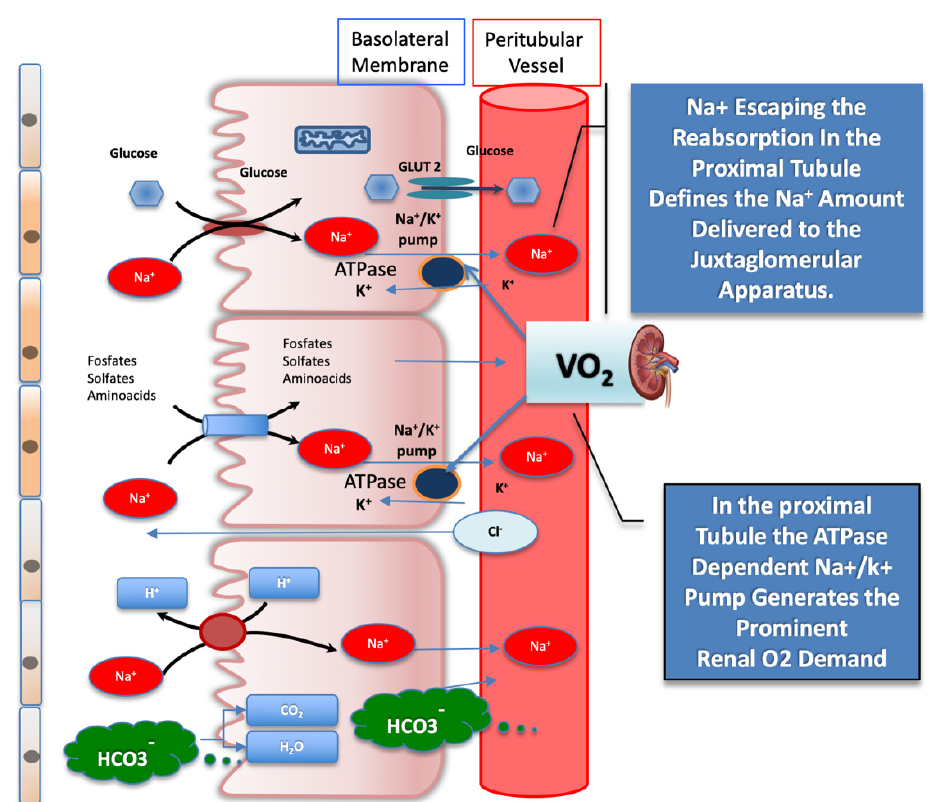
Figure 2. Schematic illustration of filtrates reabsorbed from the glomerular proximal tubule activated by sodium-glucose co-transporter (SGLT) 2, which operates in the glomerular proximal tubule. The SGLT2, the bicarbonate reabsorption, and the Na + /K + ATPase, which provides sodium energy to drive both, are represented. The active reuptake of bicarbonate and of other solutes, coupled with Na + , drives the highest tissue O 2 consumption in the kidney. The amount of Na + escaping the reabsorption in the proximal section tubule is sensed by the juxtaglomerular apparatus and sets the afferent arteriole tone. See text for details. GLUT2 = glucose transporter 2; SGLT2 = sodium-glucose co-transporter 2.